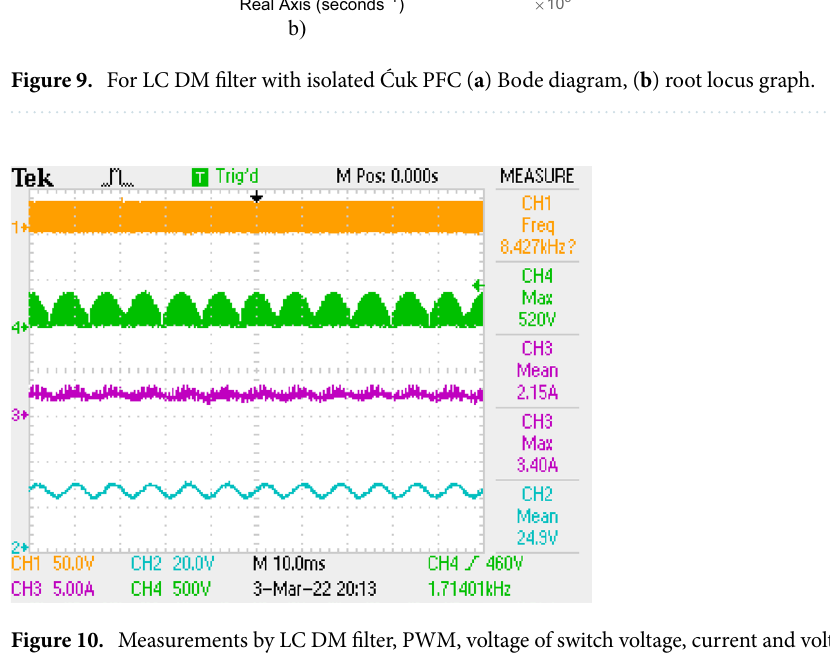
Figure 10. Measurements by LC DM filter, PWM, voltage of switch voltage, current and voltage of